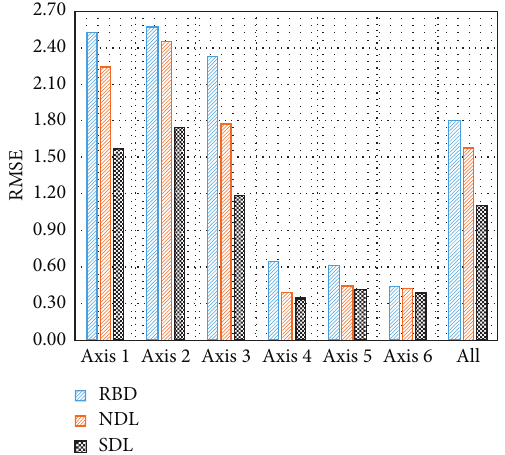
Figure 5: Cross average prediction results.